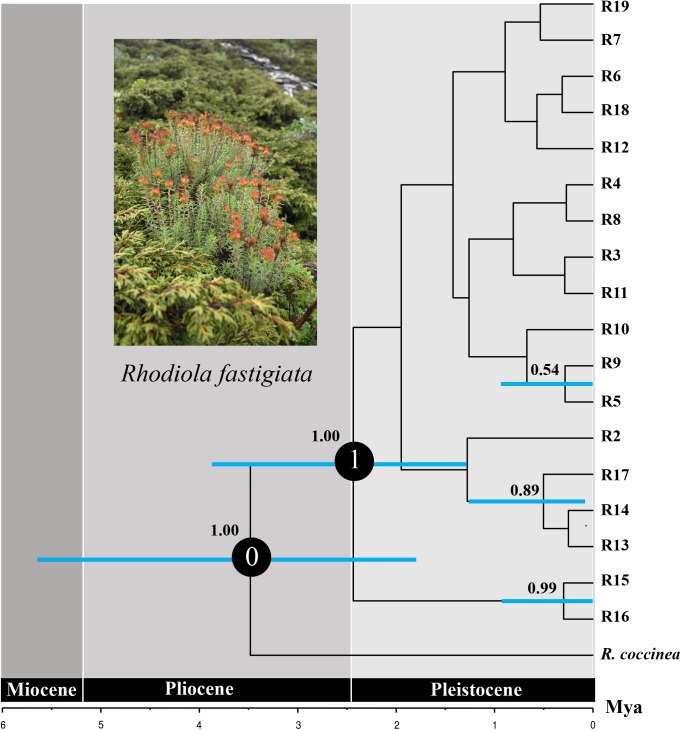
Divergence time of R. fastigiata based on ITS ribotypes estimated with BEAST. Blue bars indicate 95% highest posterior density intervals. Numbers on the branch represent posterior probability of each node. The vertical red line on the tree tips indicates the Holocene.